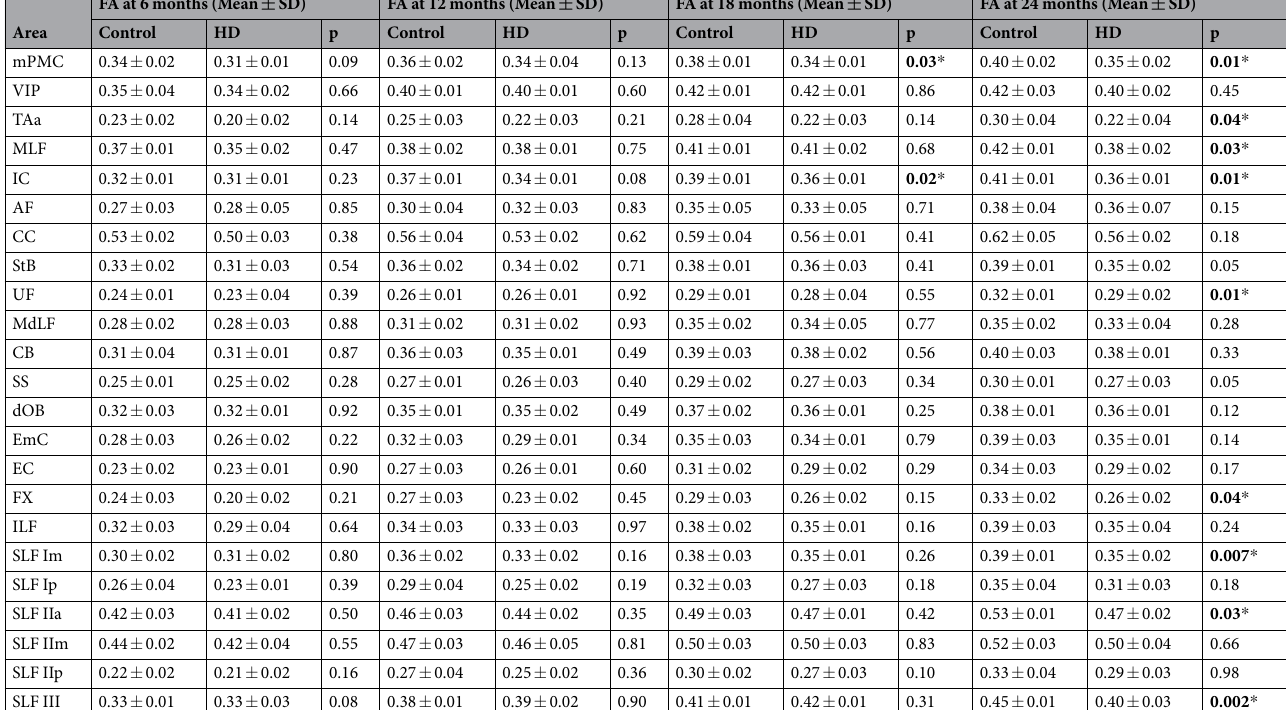
Table 3. FA group difference at ages from 6 to 24 months. The data were tested with a two-way ANOVA and post-hoc analysis with significant level of p < 0.05 ( * ). SD: standard derivation. FA: fractional anisotropy.